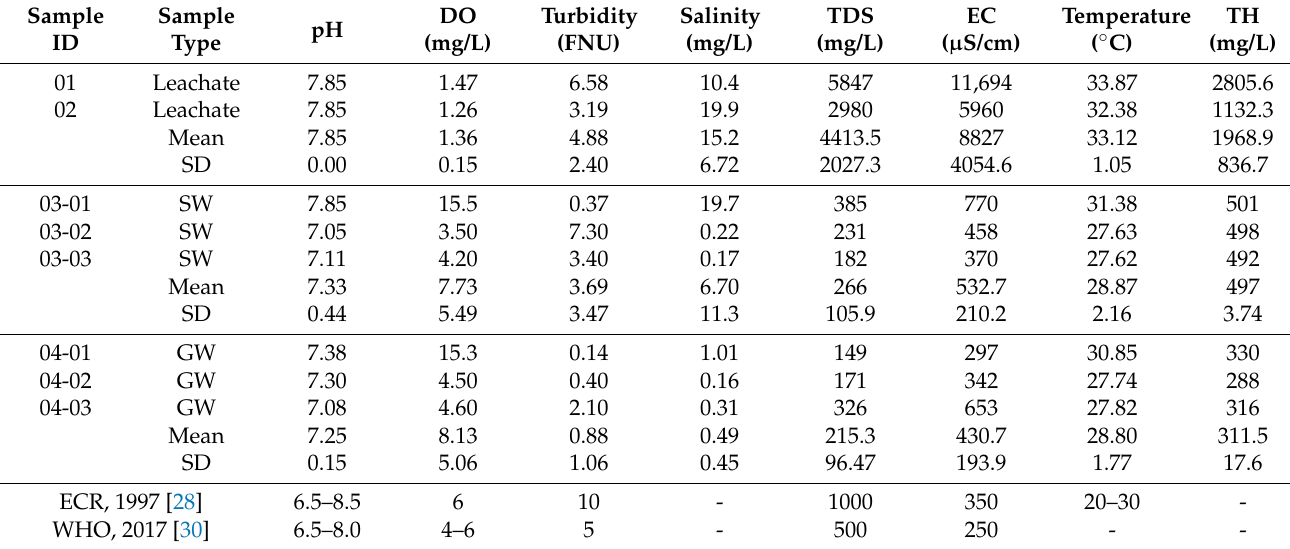
Table 3. Physicochemical parameters of leachate and water